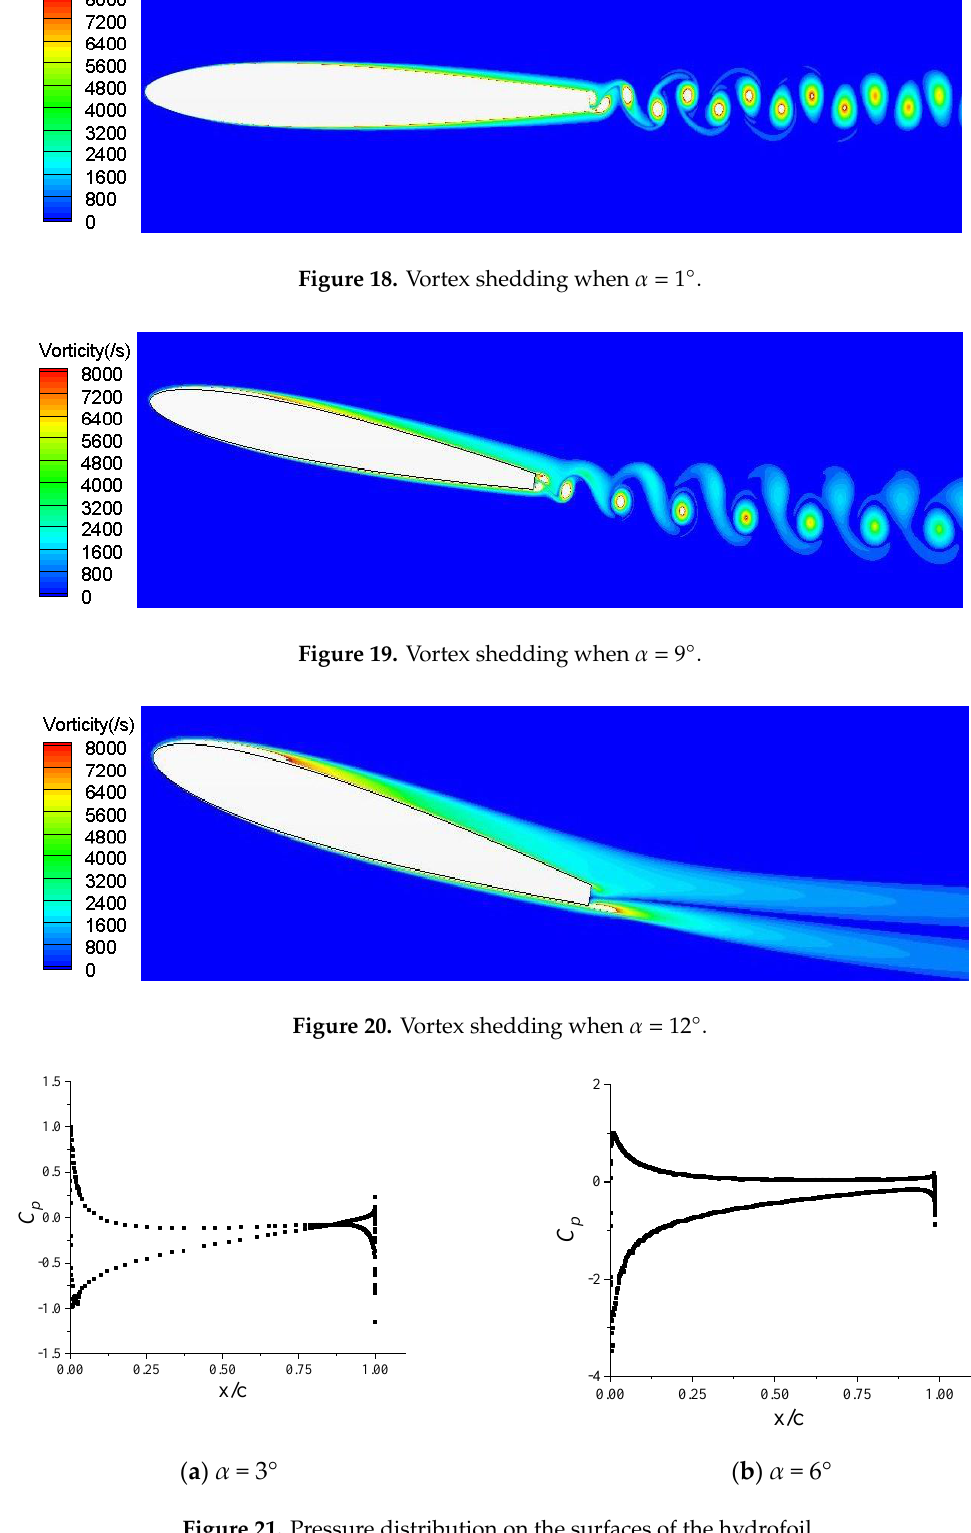
x/c Figure 22. Surface pressure distribution of the hydrofoil when α = 12°. 0 t Figure 23. Lift curve of the hydrofoil when α = 12°. 3.5. Effects of Hydrofoil Thickness Based on the NACA00 series of hydrofoil models, we designed a set of hydrofoil models with a trailing-edge thickness and chord length of b = 2.69 mm and c = 88 mm, respectively. These models